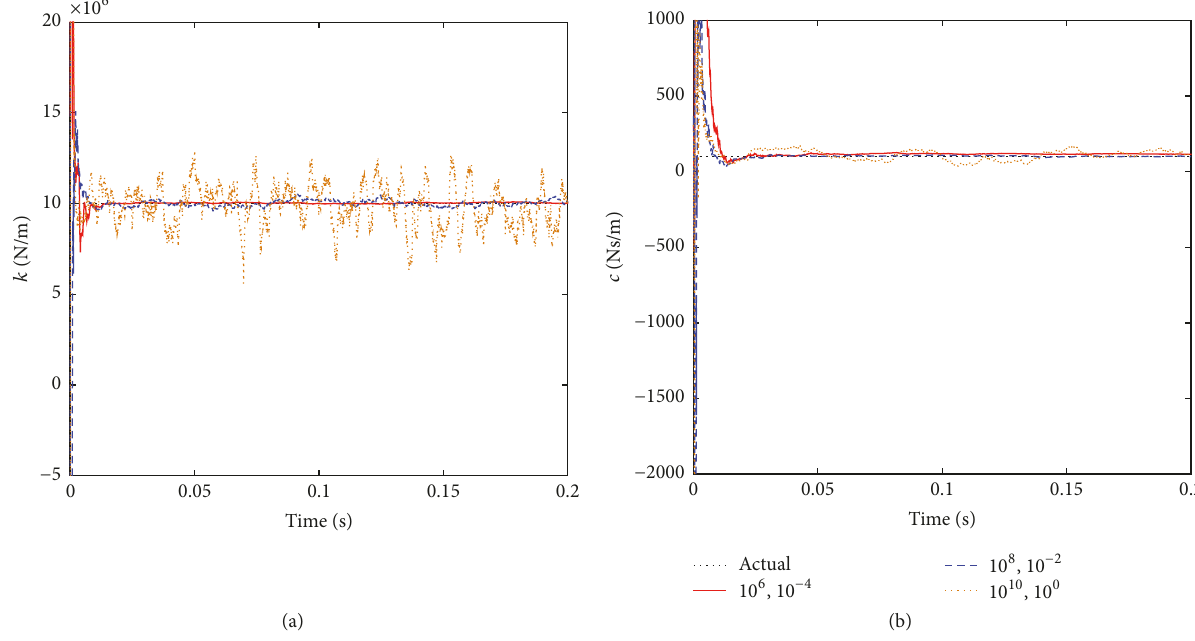
Figure 16: The actual and identified stiffness and damping of the vibration isolator.